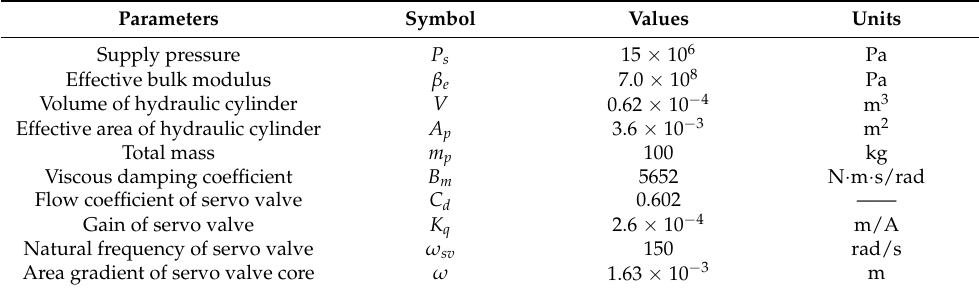
Table 1. Main parameters of the electro-hydraulic servo displacement control experimental